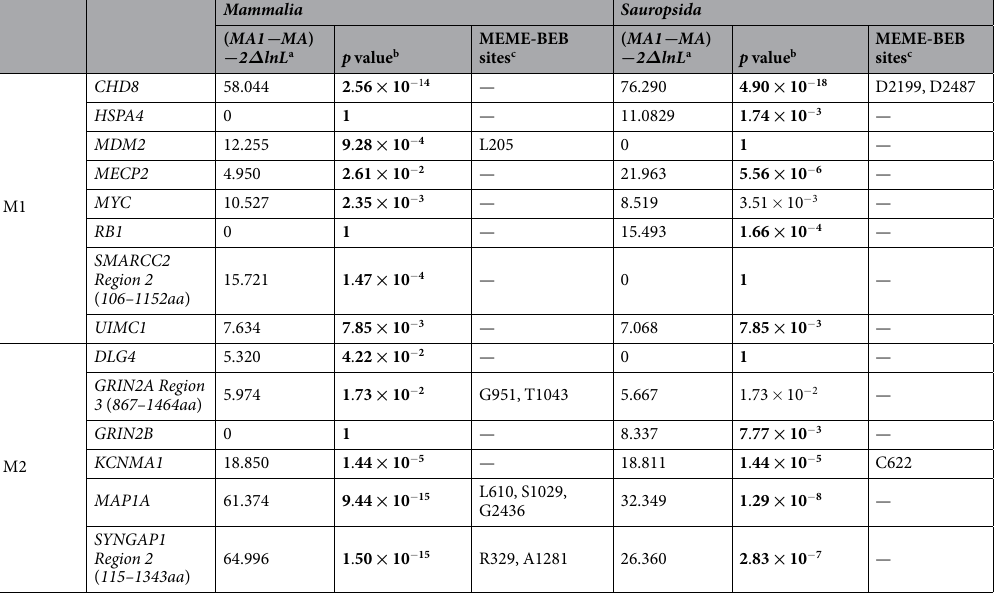
Table 1. Likelihood ratio test statistics for models of variable selective pressure along mammalian and sauropsidan branches (codon frequency:F3 × 4). a 2 Δ lnL: twice the difference of the natural logs of the maximum likelihood of the models being compared. b p values are FDR corrected. c Positions refer to the human sequence (see Supplementary Table 1, Supplementary material). Bolded p -values indicated LRTs confirmed by appling the F61 codon frequency model (see Supplementary Table 1, Supplementary